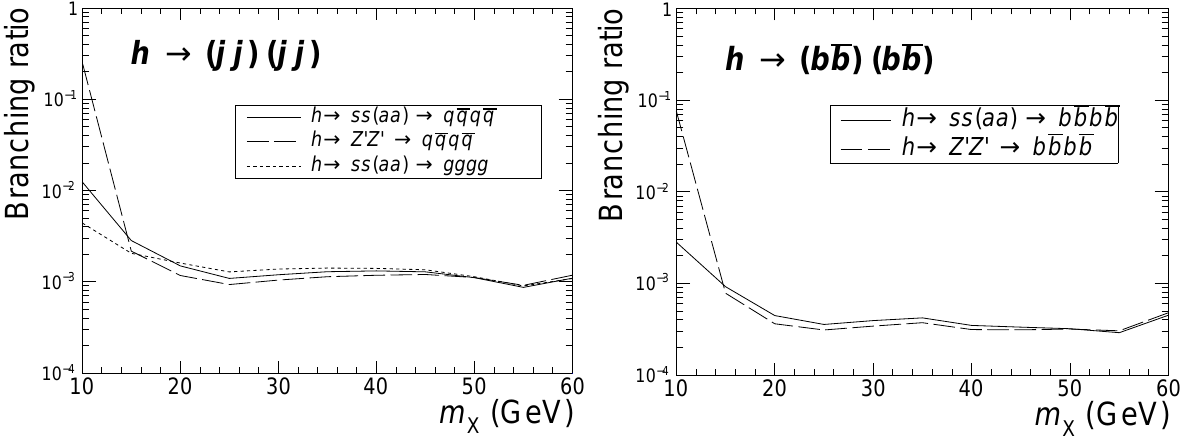
Figure 12. Ninety-five percent confidence bounds on branching ratios for Higgs decay into a pair of lighter particles, for a com energy of 240 GeVand Depending on the mass, model, and decay mode, branching ratios down to can be